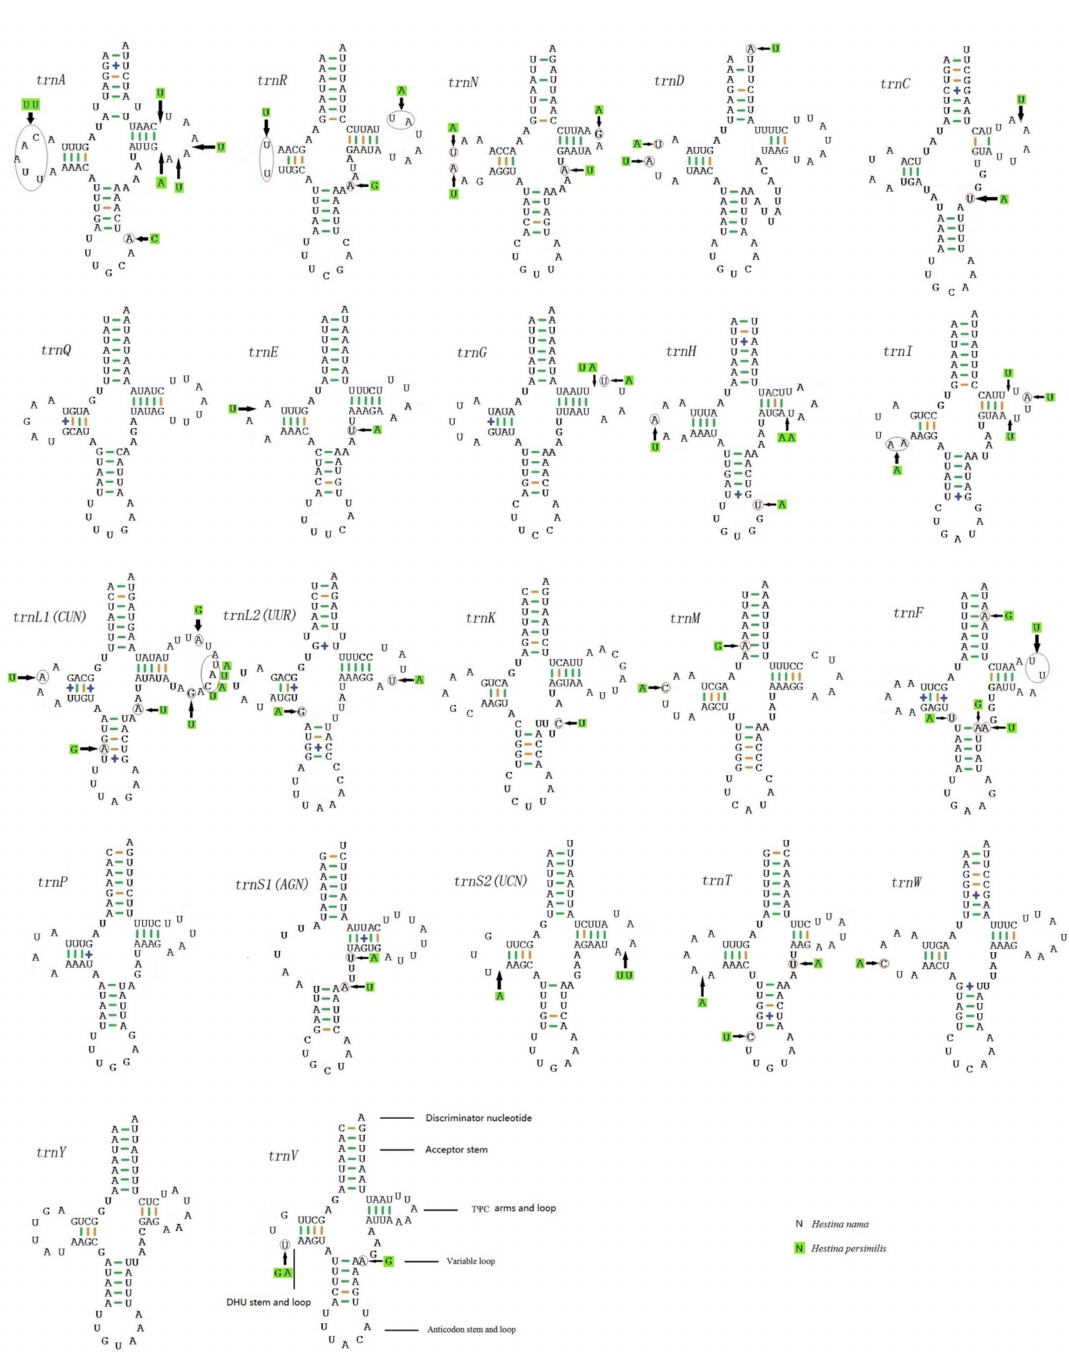
Figure 5. Predicted secondary cloverleaf structure for the tRNAs of Hestina persimilis and Hestinalis nama . Dashes (–) and pluses (+) indicate the Watson–Crick base pairings and G-U bonds,